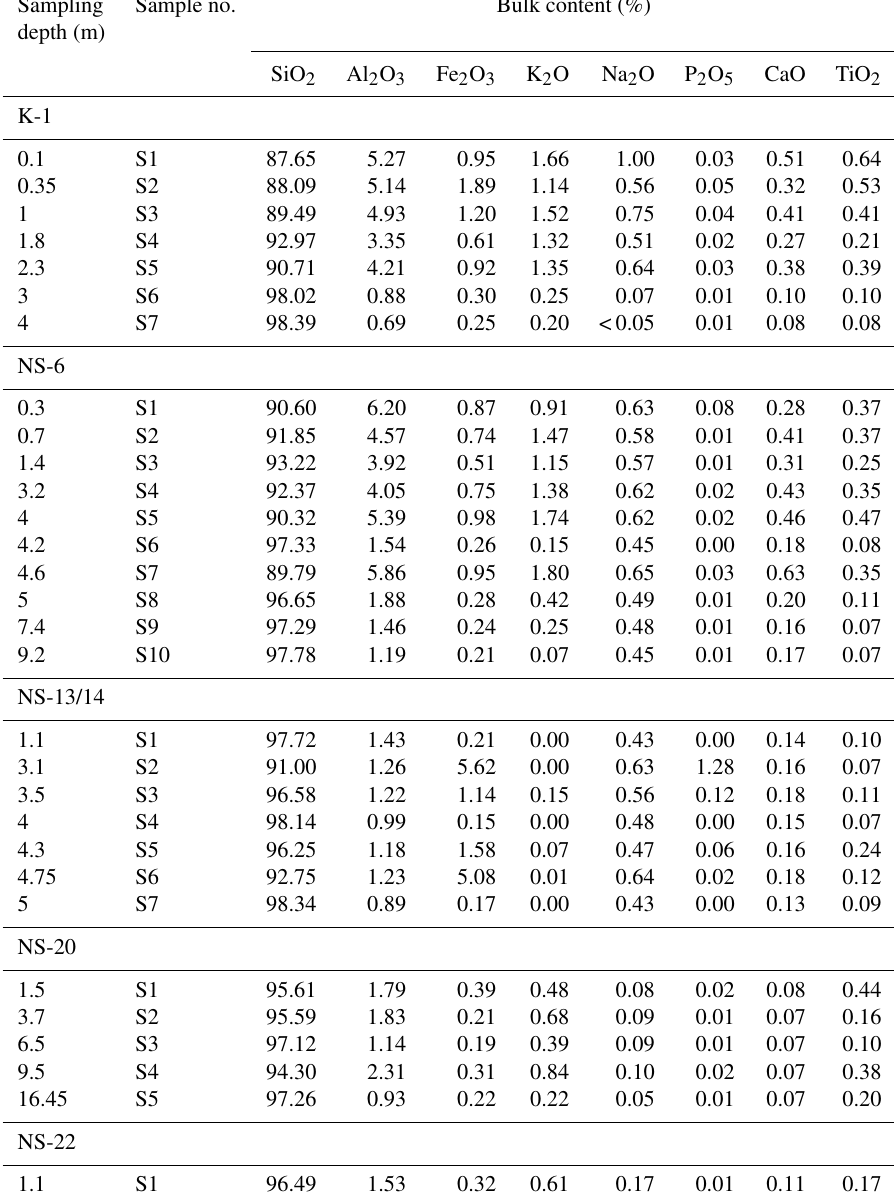
Table A1. Bulk content of chemical elements.